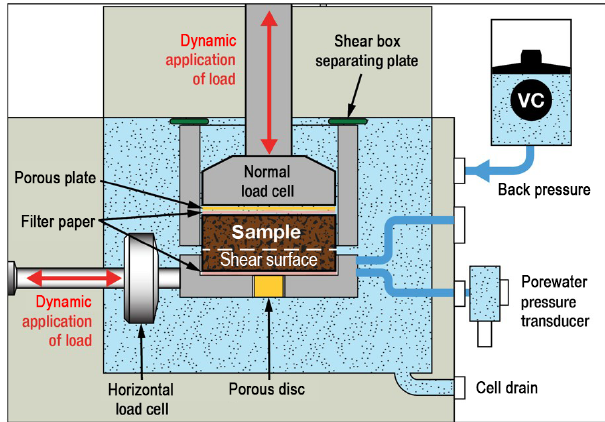
Figure 3. Schematic diagram of the dynamic back-pressured shear